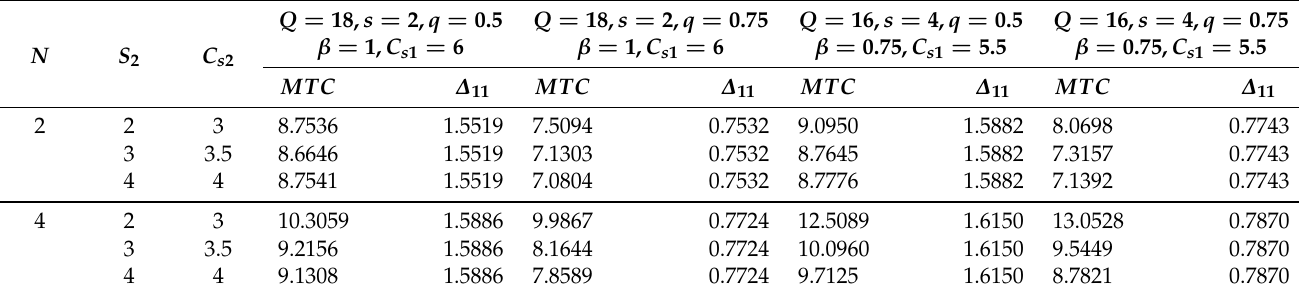
Table 2. Mean total cost vs. Customer lost.